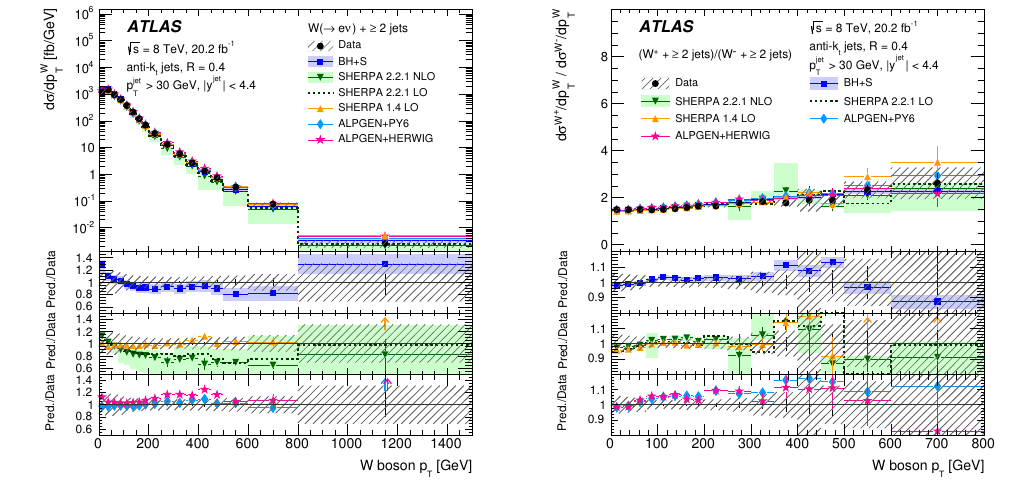
Figure 12 . Di(cid:11)erential cross sections for the production of W bosons (left) and the W + =W (cid:0) ratio (right) as a function of the W p T for events with N jets (cid:21) 2. The last bin in the left (cid:12)gure includes values beyond the shown range. For the data, the statistical uncertainties are indicated as vertical bars, and the combined statistical and systematic uncertainties are shown by the hatched bands. The uppermost panel in each plot shows the di(cid:11)erential cross sections, while the lower panels show the ratios of the predictions to the data. The theoretical uncertainties on the predictions are described in the text. The arrows on the lower panels indicate points that are outside the displayed range.